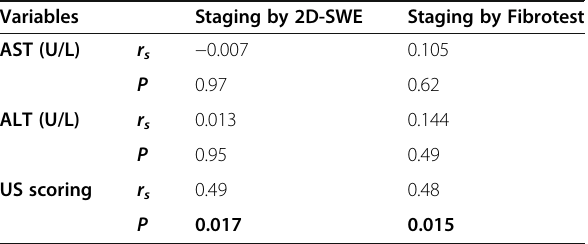
Table 4 Degree of concordance between shear wave elastography (2D-SWE) and Fibrotest and liver enzymes levels in the studied patients